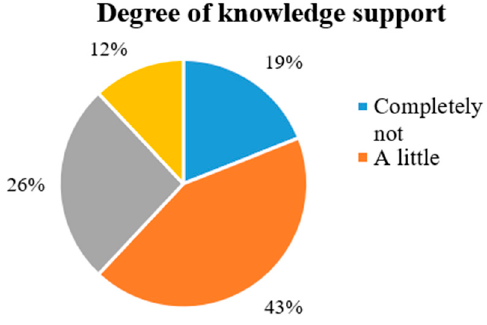
Figure 7. Degree of knowledge support in OHCs. Table 7. Evaluation results of 100 health-related websites by investigating how domain knowledge affects OHCs.